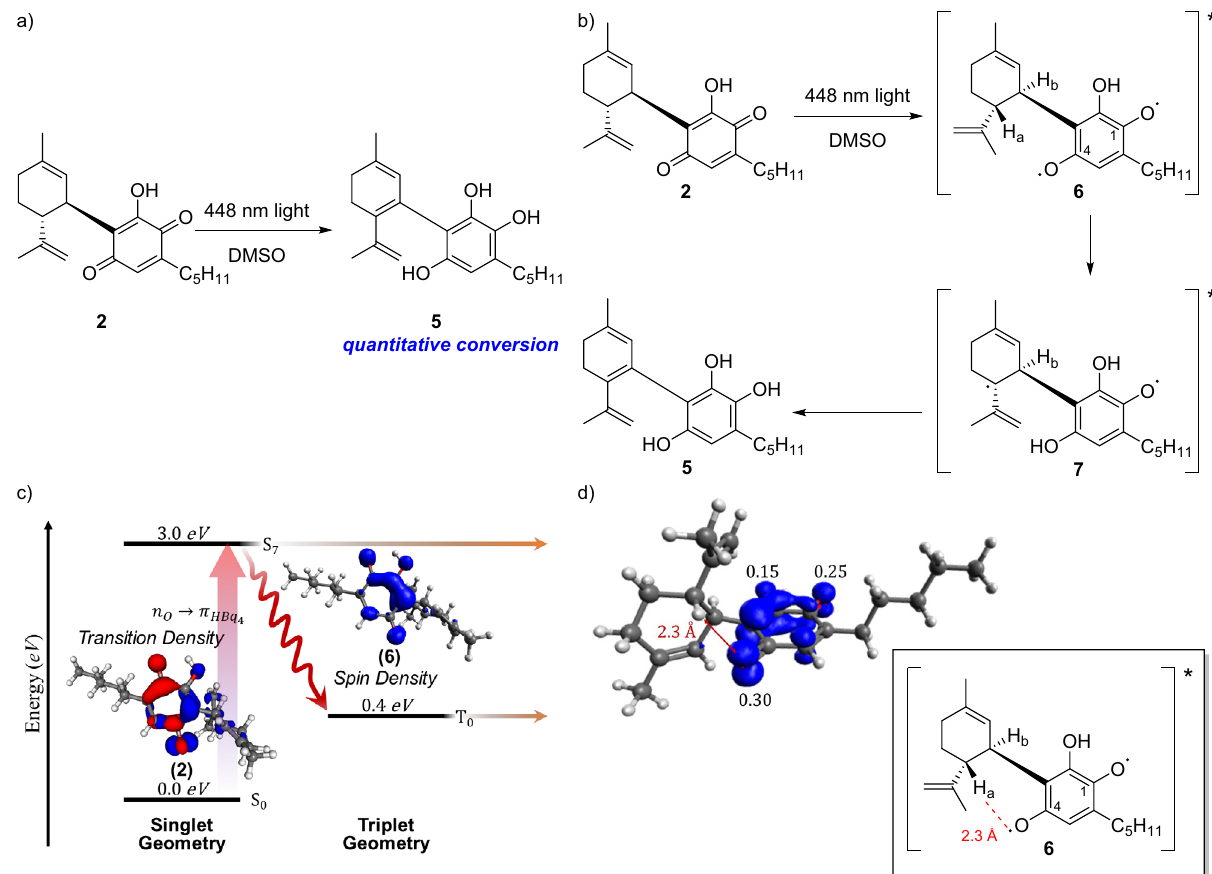
Figure 3. Mechanism of the photo-induced HU-331 light isomerisation. Formation of highly reactive cannabinoid hydroxyquinol ( 5 ). ( a ) Photochemical synthesis of hydroxyquinol ( 5 ) from HU-331 ( 3 ). ( b ) Proposed mechanism of formation. ( c ) Energies of the ground state and key excited states of HU-331. ( d ) Molecular model showing the key distance between the hydroxyquinol radical and the C–H on the limonene